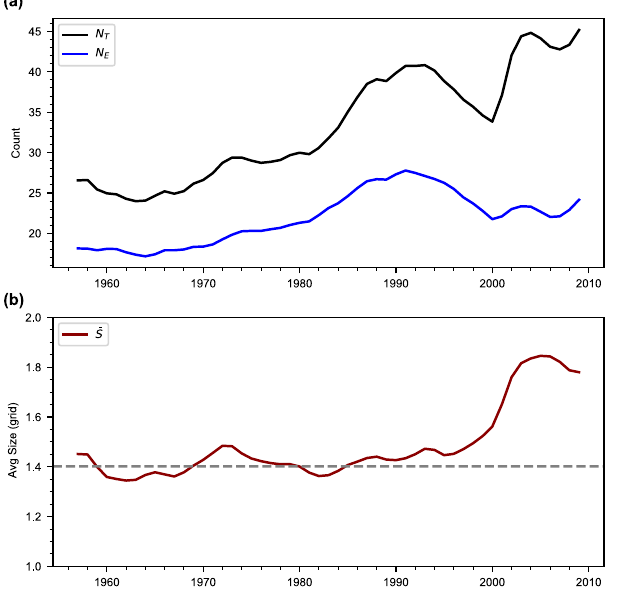
Figure 1. Temporal variation of extreme rainfall events over Central India. Smoothed time series of: ( a ) total number of 1° × 1° grids with extreme rainfall in a summer monsoon season ( N T ) and the number of extreme rainfall events ( N E ); ( b ) average size ( S ) of extreme rainfall events. The dashed line is 1951–1980 period average. Time series shown are 11-year moving averages smoothed using a 3 point (0.25, 0.5 and 0.25) weighted averaging to highlight the long-term variations. Time series (without smoothing) of N T and S show a significant increasing trend at the 99% confidence level based on the Mann-Kendall test. The N T is equivalent to the count of extreme events reported in the past studies 4,6,18 . The analysis used the gridded rain gauge data of the India Meteorological Department 31